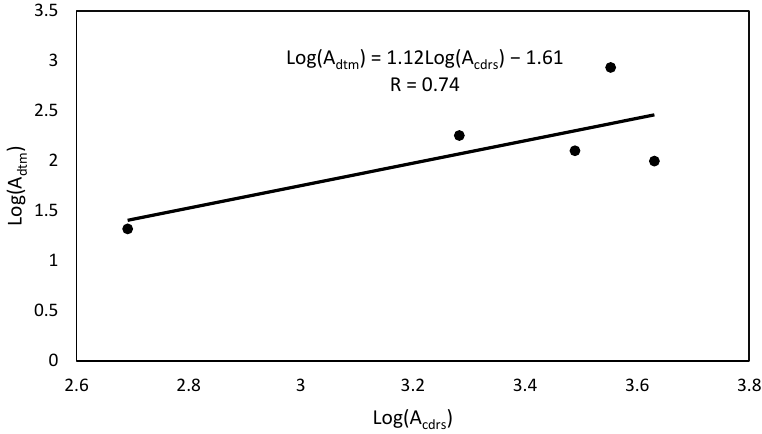
Figure 14. Comparison between the arrivals in each administrative neighborhood from CDRs ) ) and the arrivals in each administrative neighborhood from DTM ( Log ( A ( Log ( A cdrs